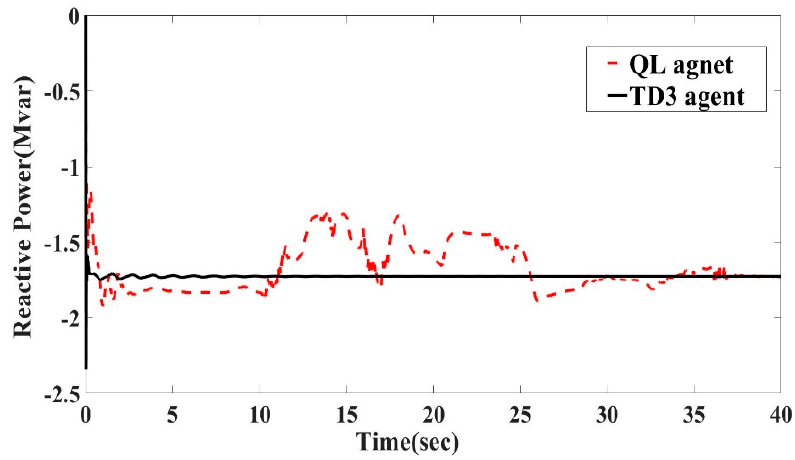
Figure 32 . DC ‐ link voltage with TD3 agent vs. Q ‐ learning.